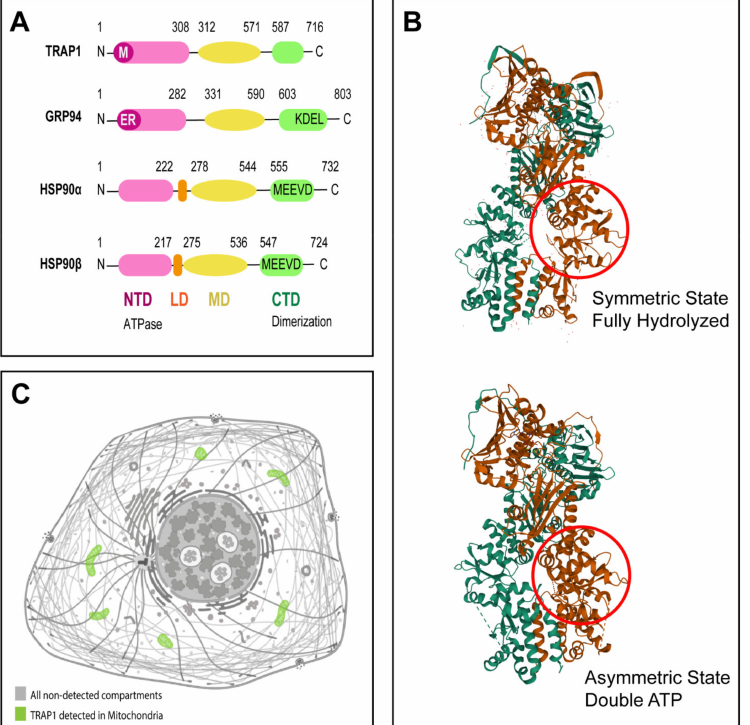
Figure 1. TRAP1 molecular structure. ( A ) Prototypic HSP90 family member has three structural domains, an N-terminal domain (NTD) responsible for ATP binding, a middle domain (MD) which is important for client binding, and a C-terminal domain (CTD) responsible for dimerization. GRP94 contains also a KDEL motif. While HSP90 α and HSP90 β contain a MEEVD motif and a linker domain (LD). Mitochondrial signal sequence present in TRAP1 is indicated with “M” and endoplasmic reticulum signal sequence present in GRP94 is indicated with “ER”. Lengths of HSP90 α , HSP90 β , GRP94, and TRAP1 are 732, 724, 803, and 704 amino acids, respectively. ( B ) 3D structures of TRAP1 dimer in different nucleotide states, with each protomer in a different color. Symmetric state of TRAP1 in fully hydrolyzed state of protein (PDB code 5TVX; image available at https://www.rcsb. org/3d-view/5TVX/1; accessed on 29 September 2021) [11–14]. Asymmetric state of TRAP1 in double ATP state (PDB code 6XG6; image available at https://www.rcsb.org/3d-view/6XG6/1; accessed on 29 September 2021) [11,13–15]. Red circle highlights substructure in middle domain that undergoes rearrangement upon nucleotide hydrolysis; reproduced with permission from RCSB